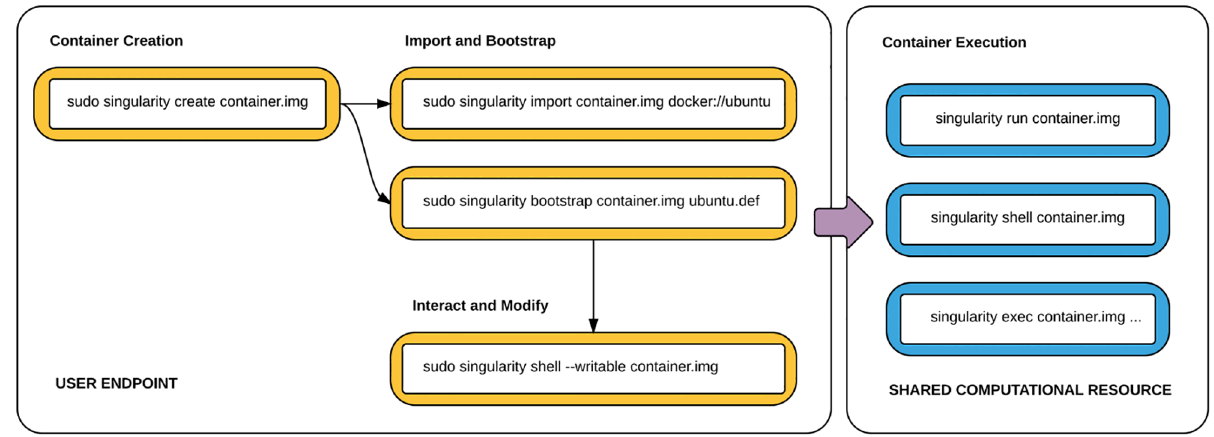
Fig 1. Singularity usage workflow. The standard SingularityUsage Workflow involvesa workingendpoint(left) where the user has root, and a containercan be created, modifiedand updated,and then transferred to a sharedcomputational resource (right) to be executedat